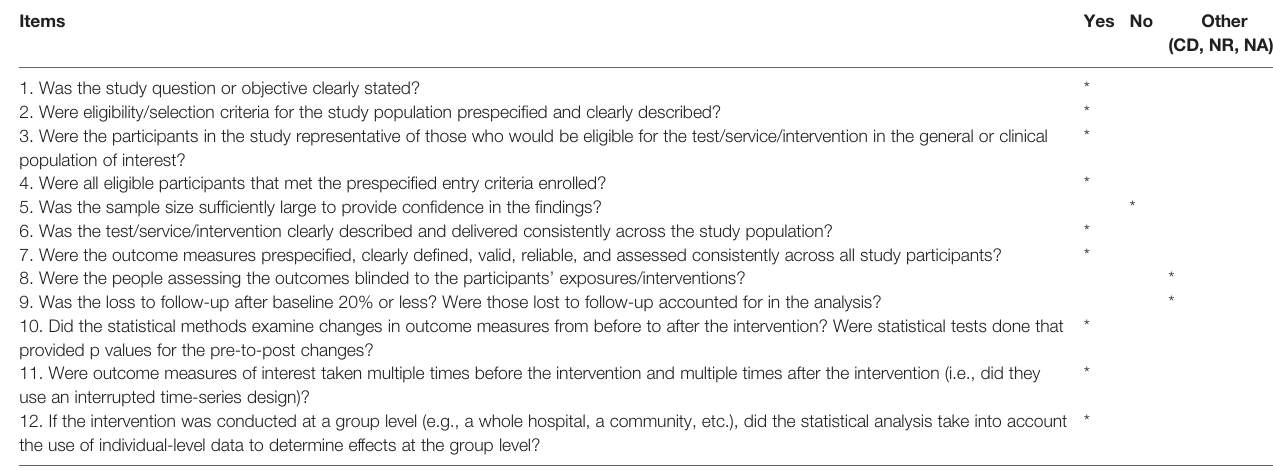
TABLE 2 | Evaluating the potential risk of bias in the included clinical